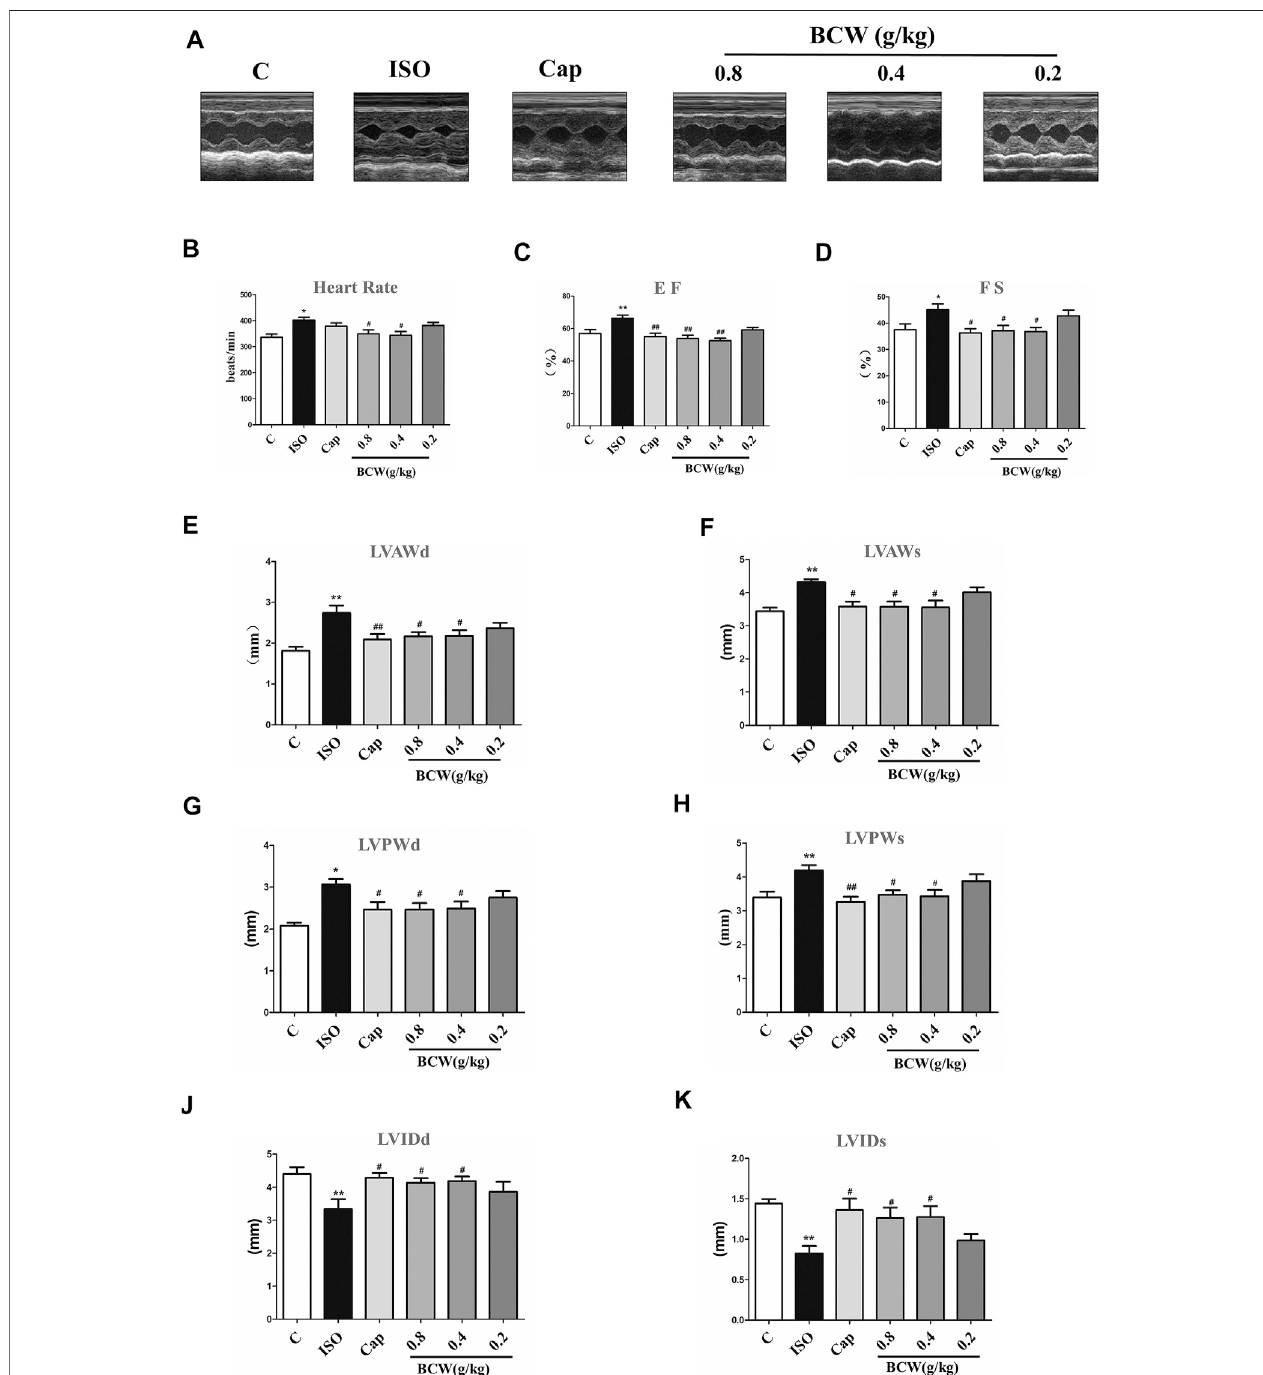
FIGURE 3 | BCW attenuated ISO-induced cardiac functional remodeling. (A) Representative M-mode tracings of echocardiography after 5 weeks of the whole experiments. (B – K) Quanti fi cationechocardiographicparameters: (B) heartrate(HR); (C) ejectionfraction (E , F) ; (D) fractionalshortening(FS); (E) leftventricular anterior wall at diastole (LVAWd); (F) left ventricular anterior wall at systole (LVAWs); (G) left ventricular posterior wall thickness at diastole (LVPWd); (H) left ventricular posterior wallthicknessatsystole(LVPWs) (I) leftventricularinternaldimensionatdiastole(LVIDd);and (J) leftventricularinternaldimensionatsystole(LVIDds);thedatawere expressed as the mean ± SE. * p < 0.05 vs. control, ** p < 0.01 vs. control; # p < 0.05 vs. ISO, ## p < 0.01 vs. ISO, n (cid:2) 10 in each group.